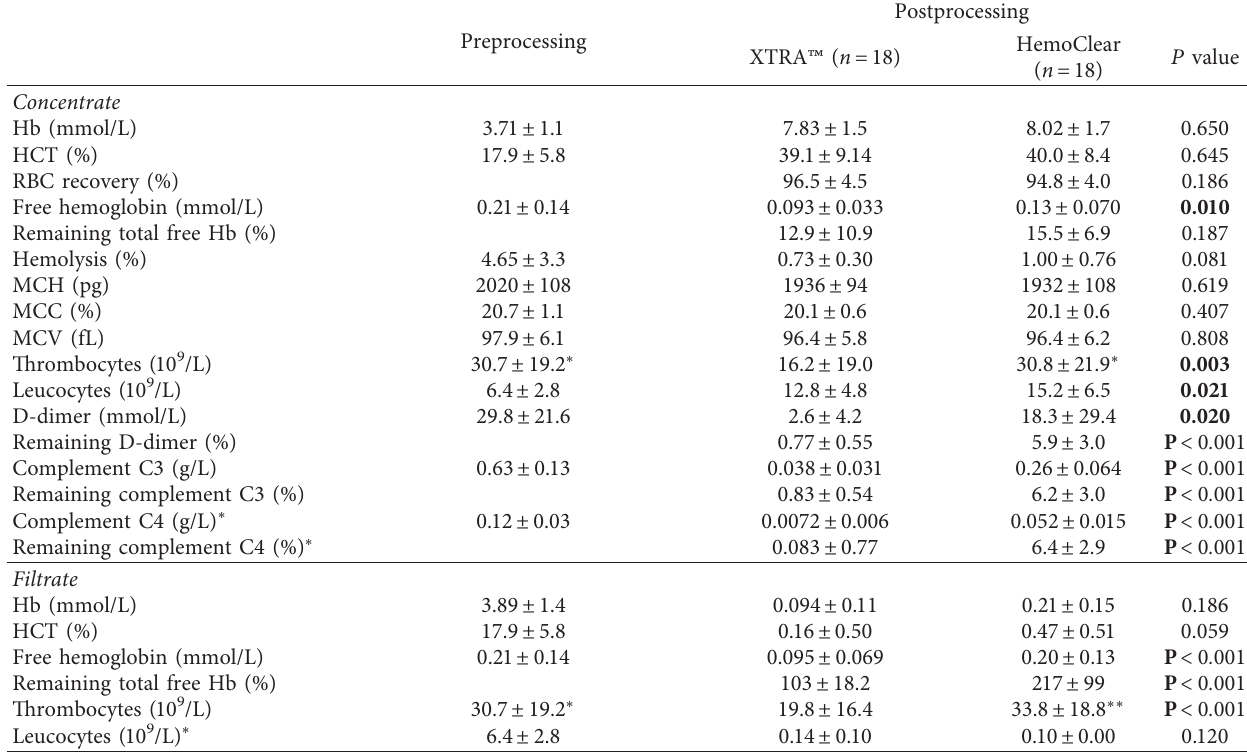
Table 1: Comparison of washing performance for the HemoClear and XTRA ™ devices.